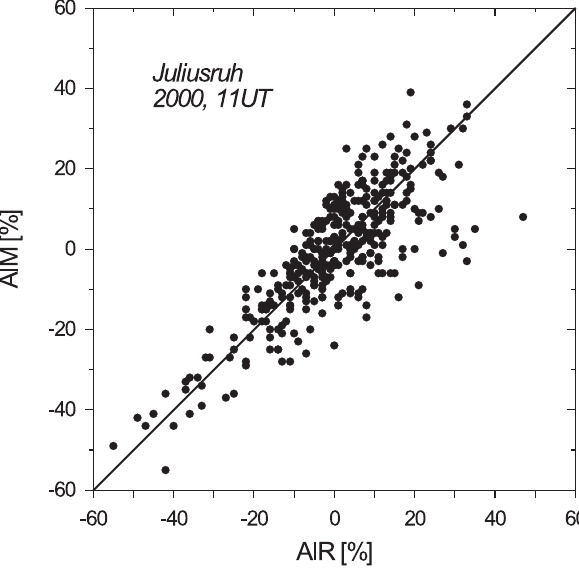
Fig. 2. Comparison of hourly AI values derived by different refer- ence values (AIM: based on median values, AIR: based on regres- sion values) using experimental ionosonde data observed in Julius- ruh at 11:00UT during the year